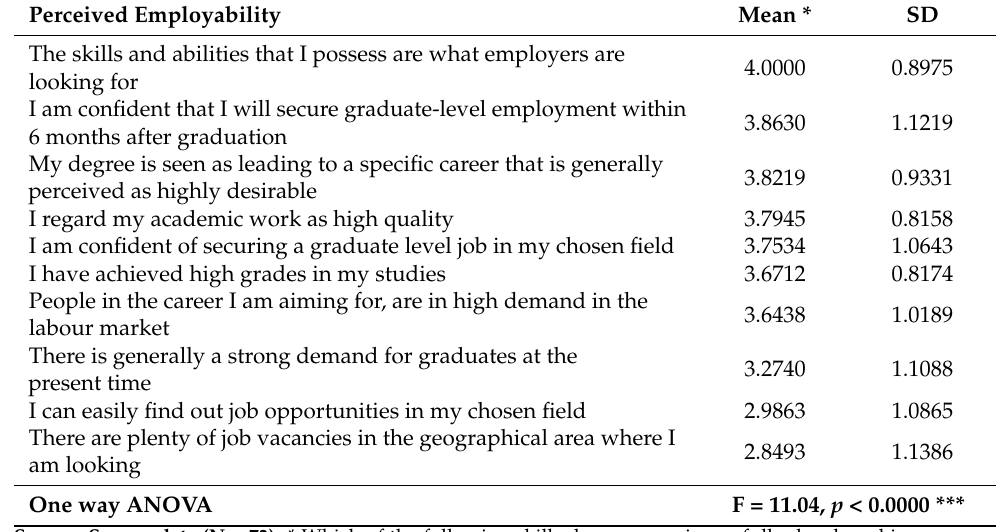
Table 8. Perceived